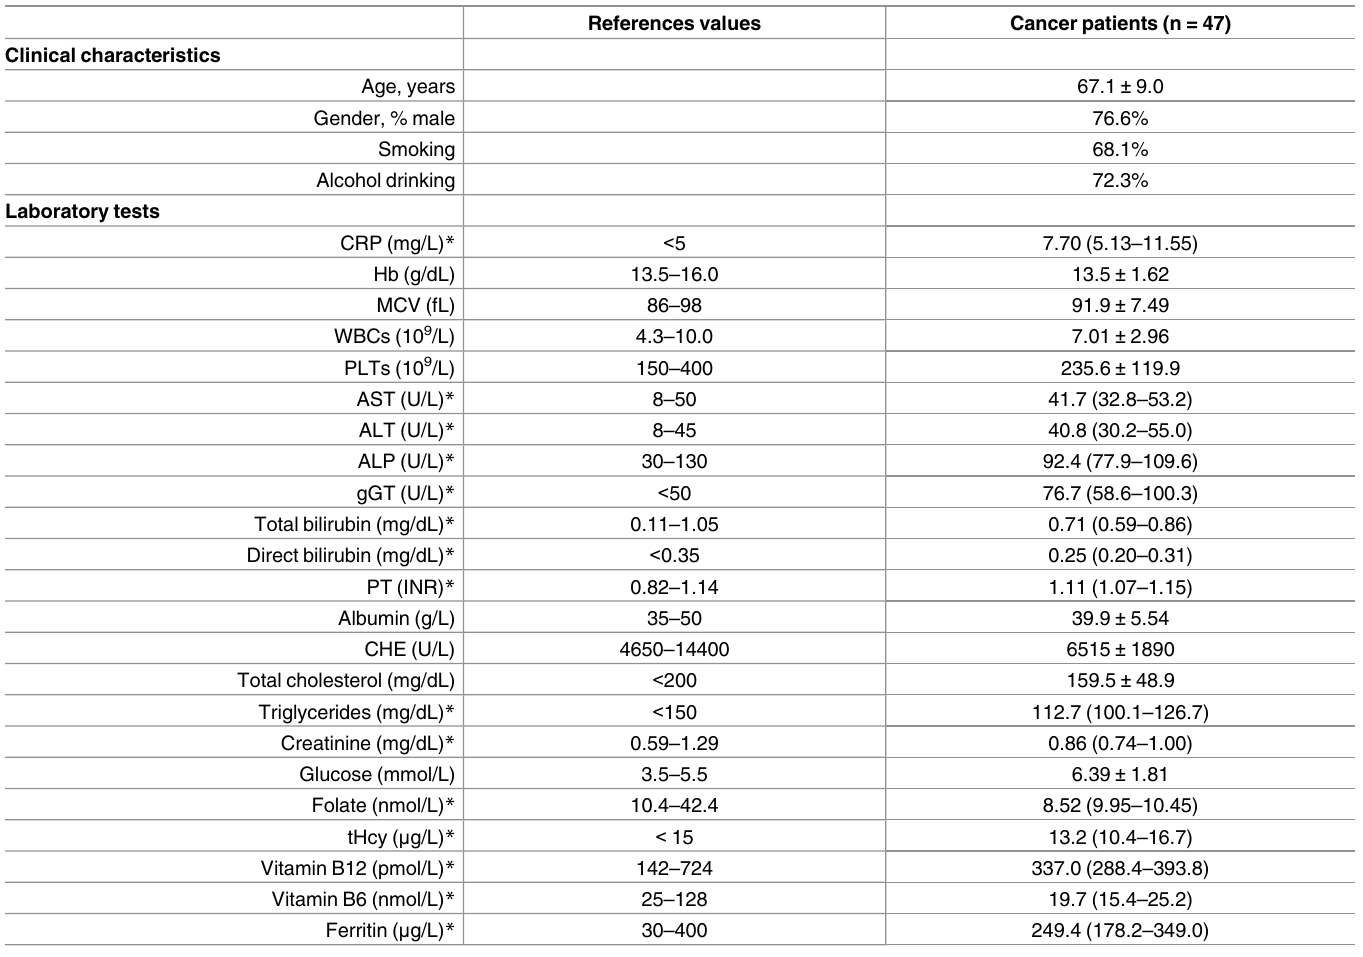
Table 1. Clinical and biochemical characteristics of primary liver cancer patients.